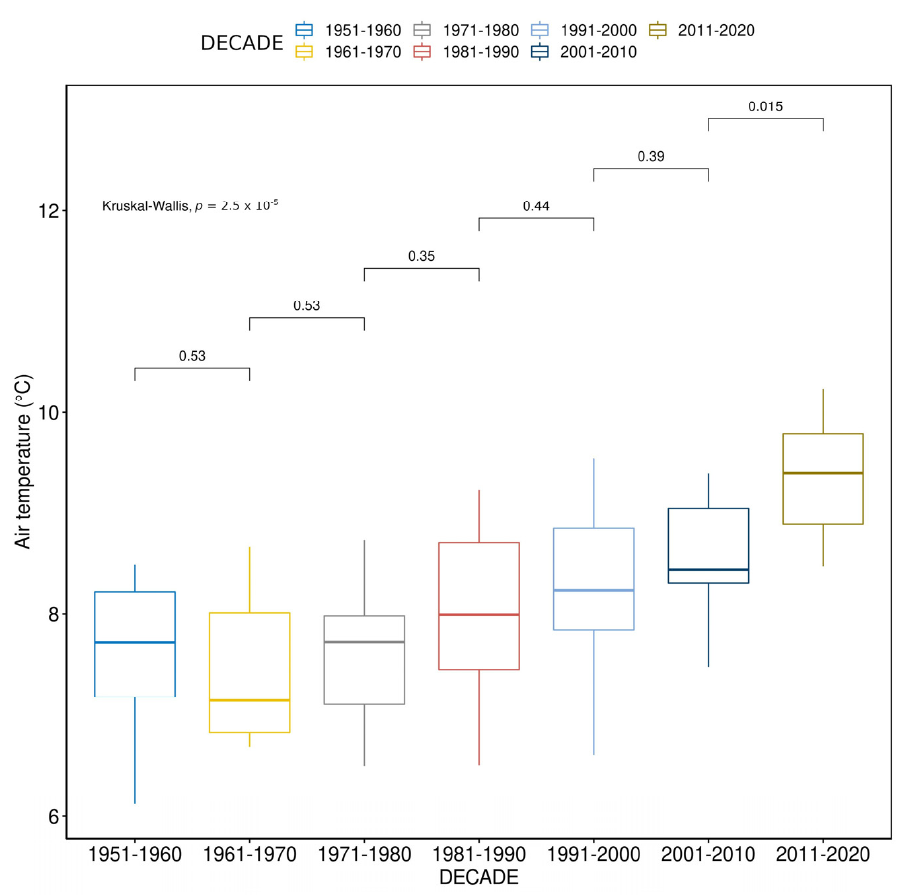
Figure 7. Box-and-whisker plots of annual average air temperature in Poland over the decades.